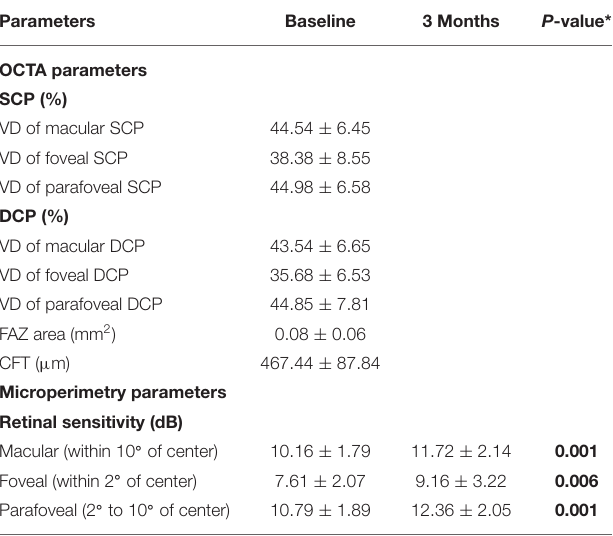
TABLE 2 | OCTA and microperimetry parameters in idiopathic ERM eyes.